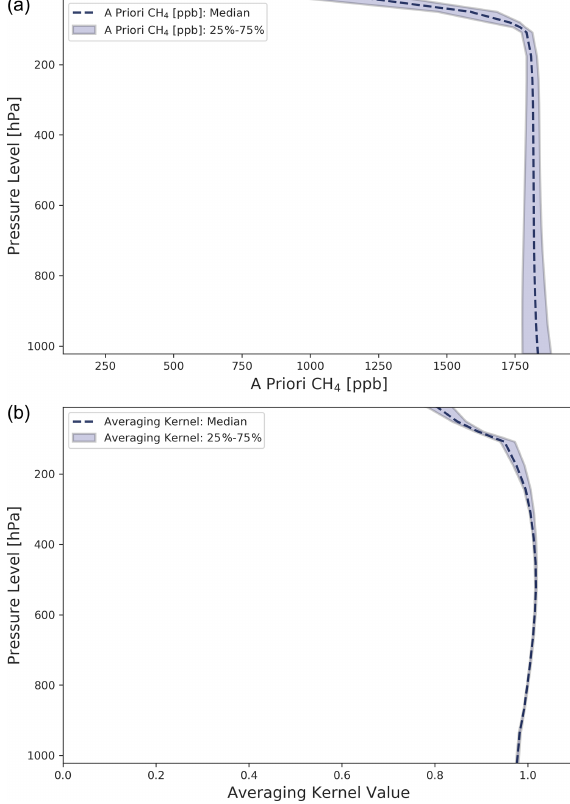
Figure 1. The average CH 4 a priori profile used in the retrievals along with the 25%–75% variation (a) . The average normalised column averaging kernel produced by the retrieval along with the 25%–75% variation, highlighting the strong sensitivity of the re- trieval to the surface (b)